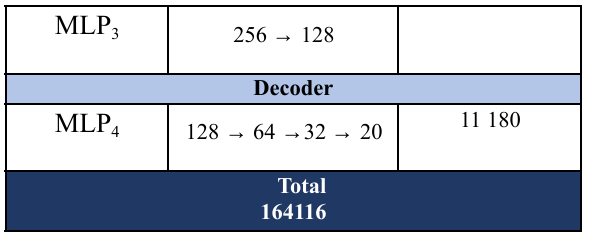
Figure 8. Performance of data augmentation techniques